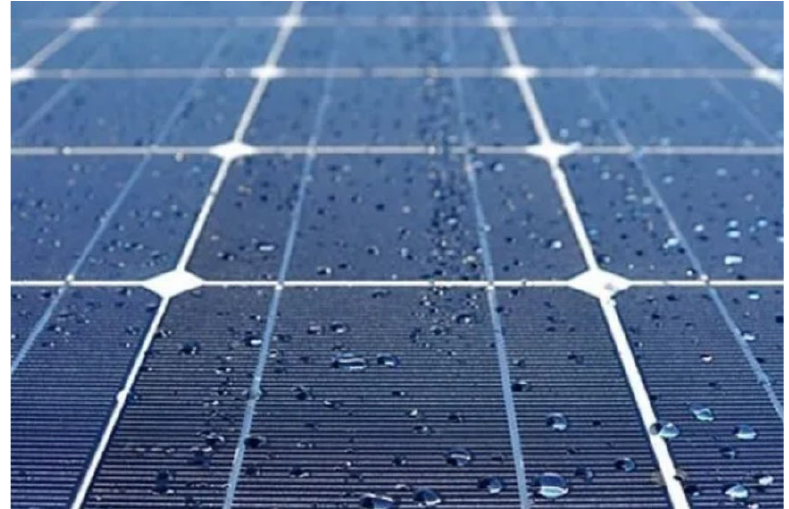
Figure 21. Super Hydrophobic Coating on PV panel [87].